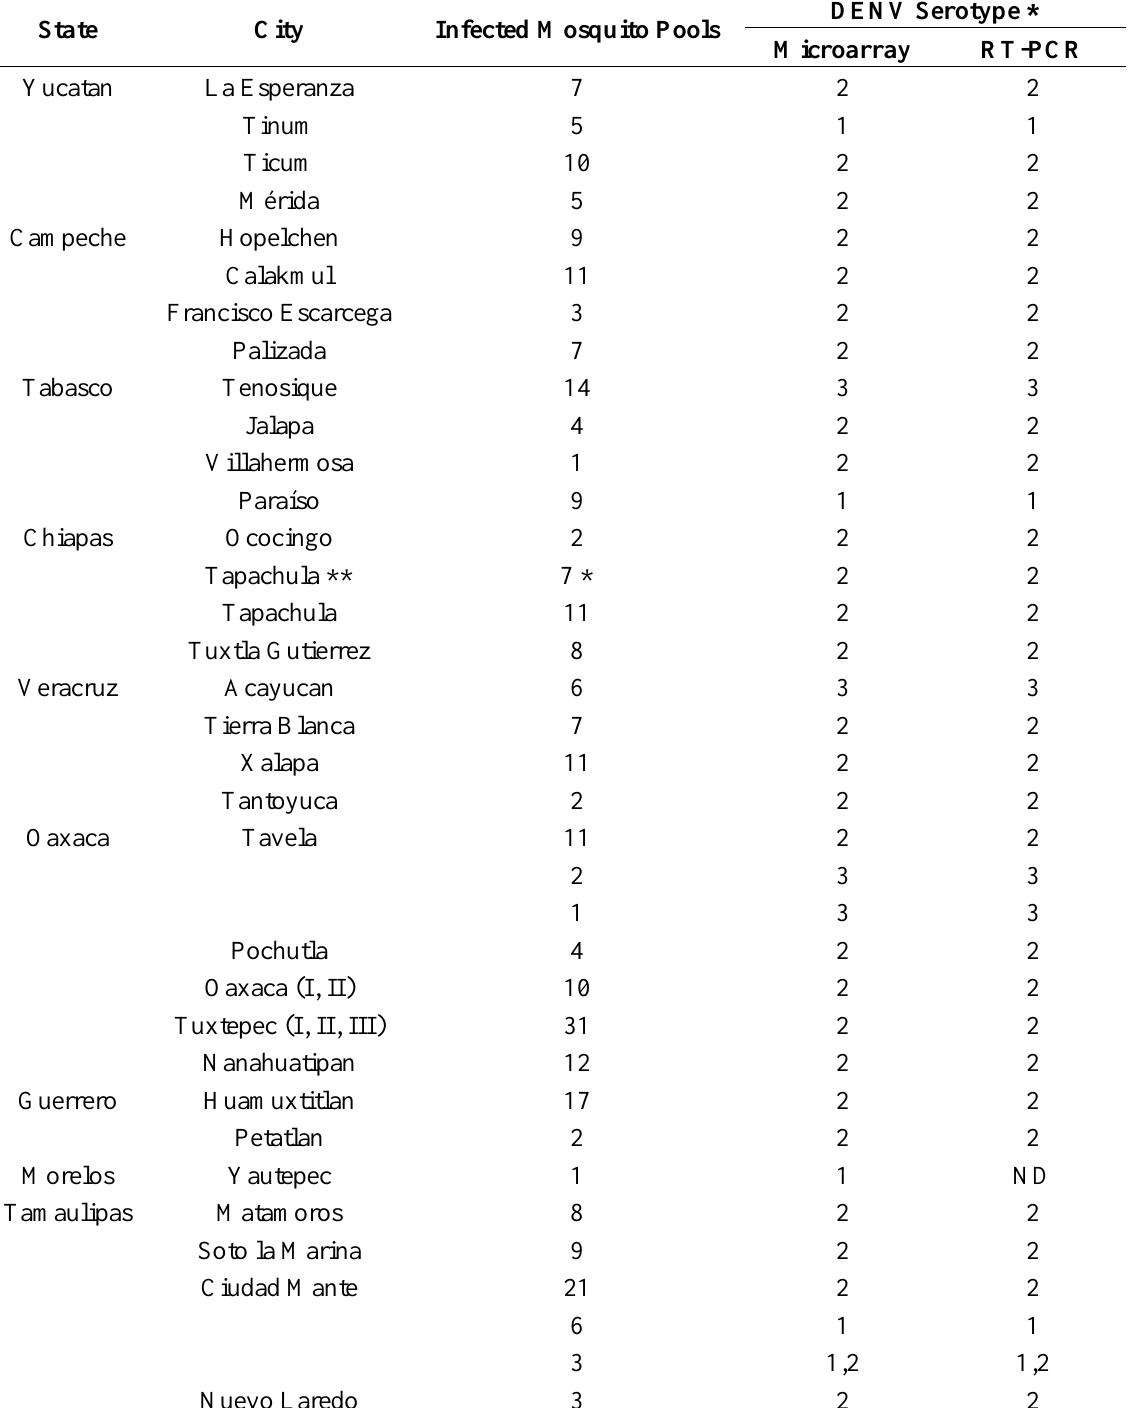
Table 4. Mosquito pools tested for DENV by microarray technology and validation by RT-PCR and agarose gel